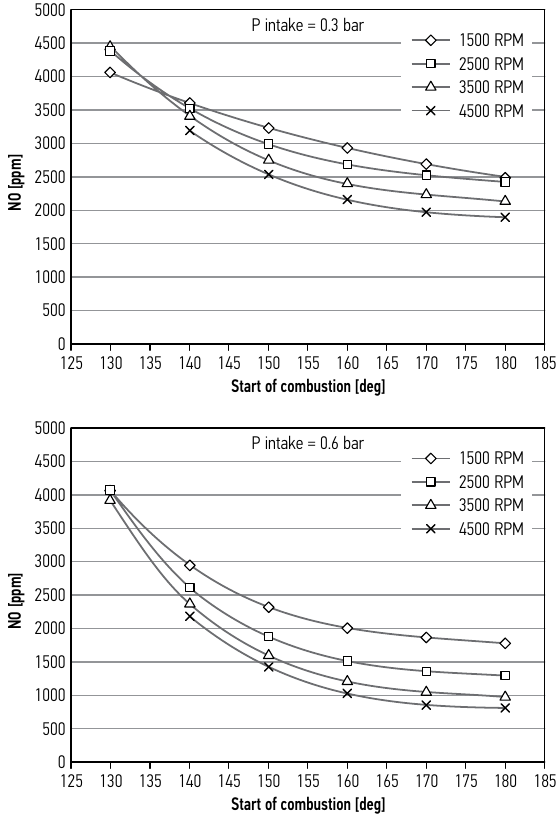
Fig. 8. NO emission as a function of combustion starting at different speeds and starting pressures